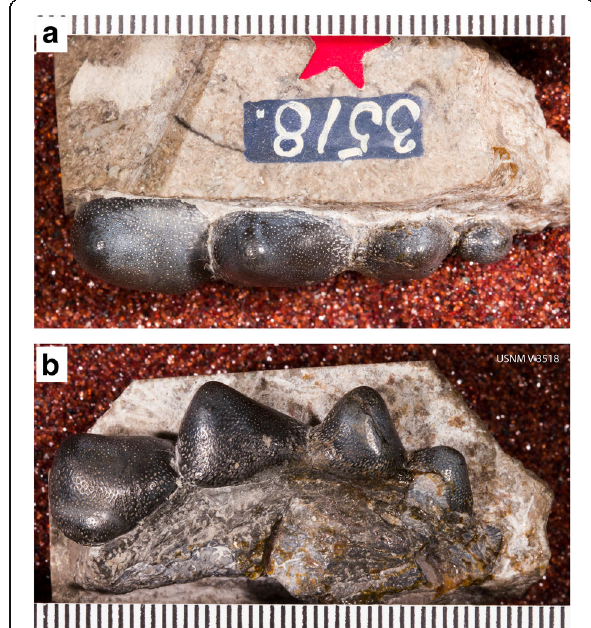
Fig. 12 Holotype of Helodus coxanus Newberry, 1897, USNM V3518. a Occlusal view. Lingual end to left. Millimeter scale divisions. b Lateral view. Lingual end to left. Millimeter scale divisions. A drawing of this specimen was published as Newberry, 1897 ([34], pl. 24,